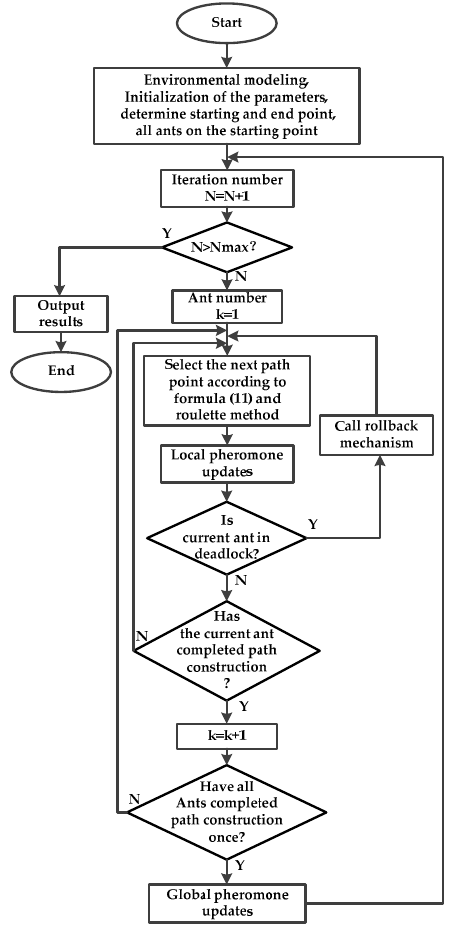
Figure 6. The flow chart of ant colony optimization, which corresponds to the steps